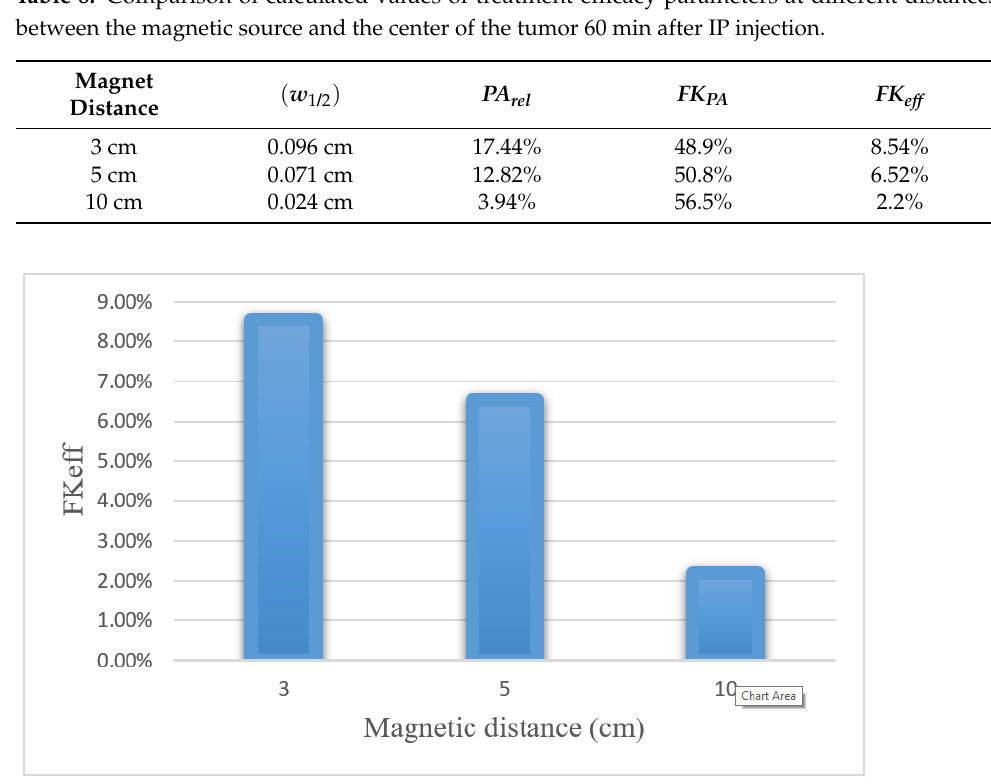
Figure 21. The comparison of the mean concentrations of the free drug ( C F ) in tumors over 60 min treatment of IP chemotherapy using drug-coated magnetic nanoparticles at different distances between the magnetic source and the tumor center.